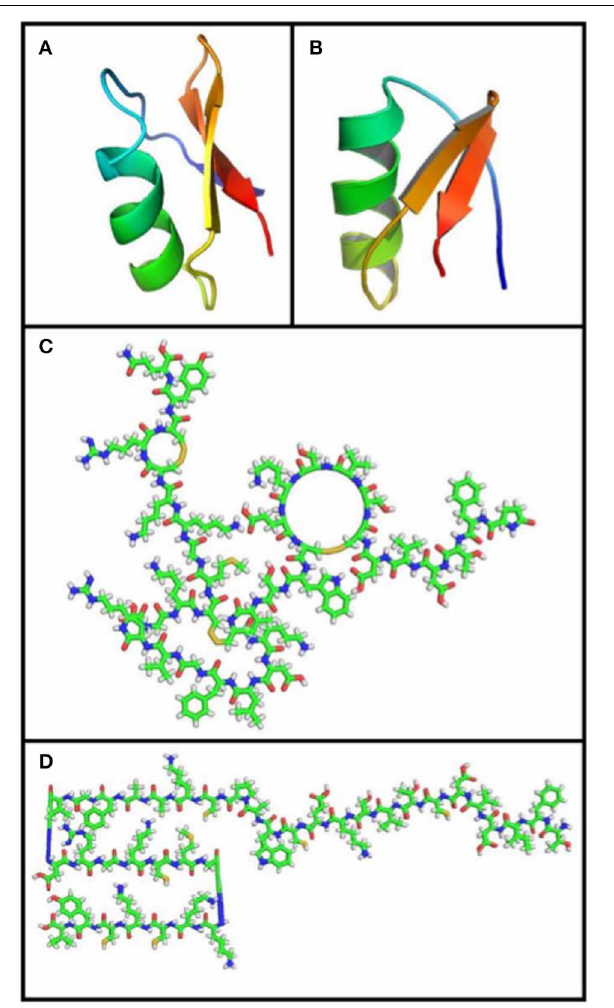
FIGURE 4 | Toxin structure. (A) Charybdotoxin: PDB ID 2CRD; (Bontems et al., 1992). (B) Martentoxin: PDB ID 1M2S (Wang et al., 2005). (C) Iberiotoxin: PubChem ID 16132435. (D) Slotoxin: PubChem ID 16133816. Using PyMOL Molecular Graphics System, Version 1.5.0.4 Schrödinger,